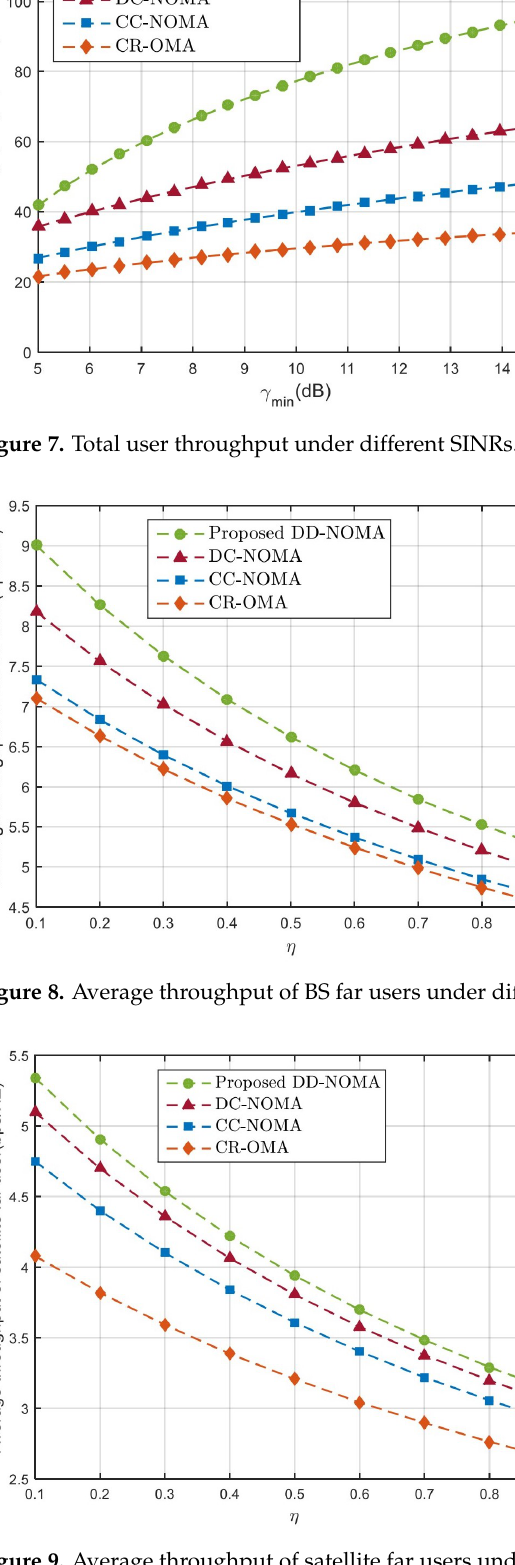
Figure 9. Average throughput of satellite far users under different η